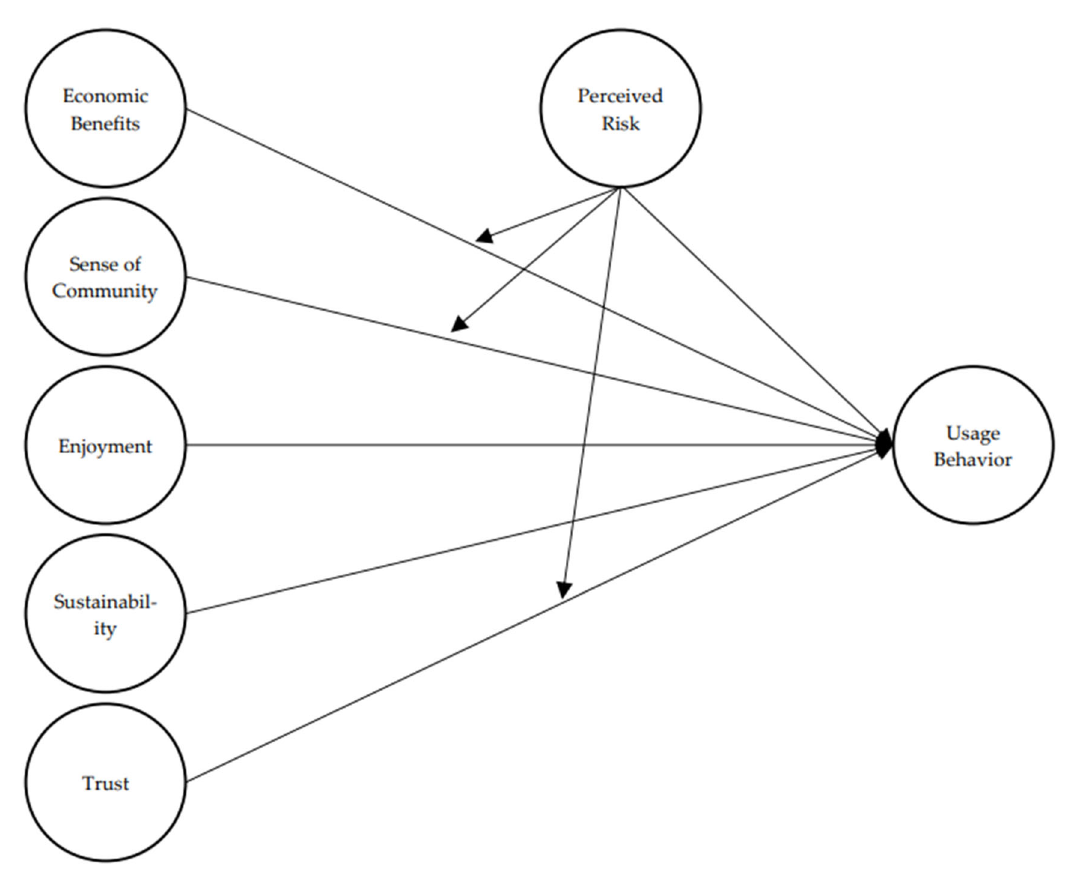
Figure 1. Research model.